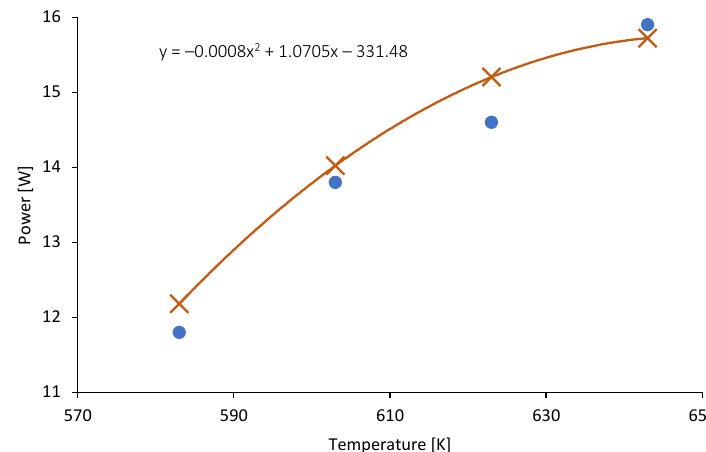
Figure 12. Variations in the generated power as a function of flue gas temperature.